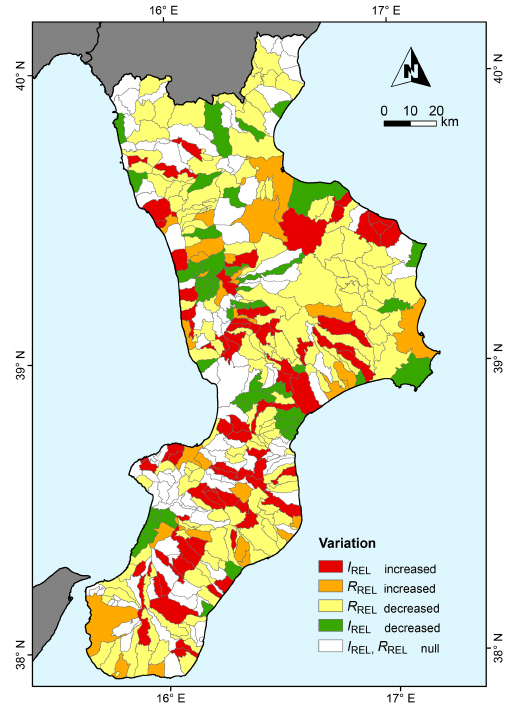
Figure 9. Map showing variations in I REL and R REL in the mu- nicipalities of Calabria, between the intermediate (1951–1980) and the recent (1981–2010) periods. Legend: Red, municipalities with an increased I REL (increased number of REL and a smaller popu- lation). Orange, municipalities with an increased R REL (increased number of REL and a larger population). Yellow, municipalities with a decreased R REL (decreased number of REL and a smaller population). Green, municipalities with a decreased I REL (de- creased number of REL and a larger population). White, munici- palities with I REL and R REL null (no REL listed in the catalogue in the intermediate and in the recent